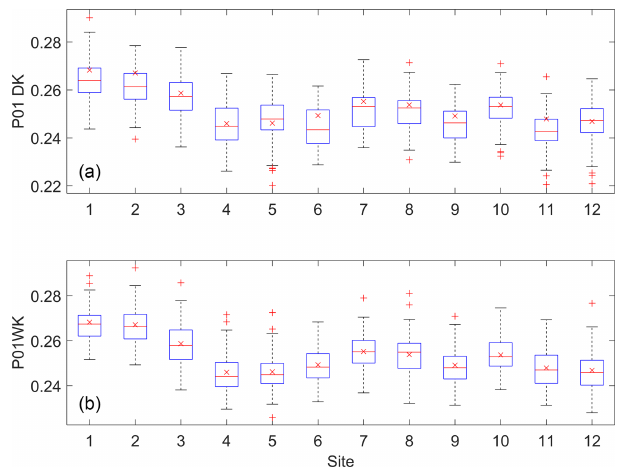
Figure 6. Box plots of the P 01 probability for the data simulated from the DKNNR model (a) and the MONR model (b) , as well as the observed ( x marker) for the 12 selected weather stations from the Yeongnam